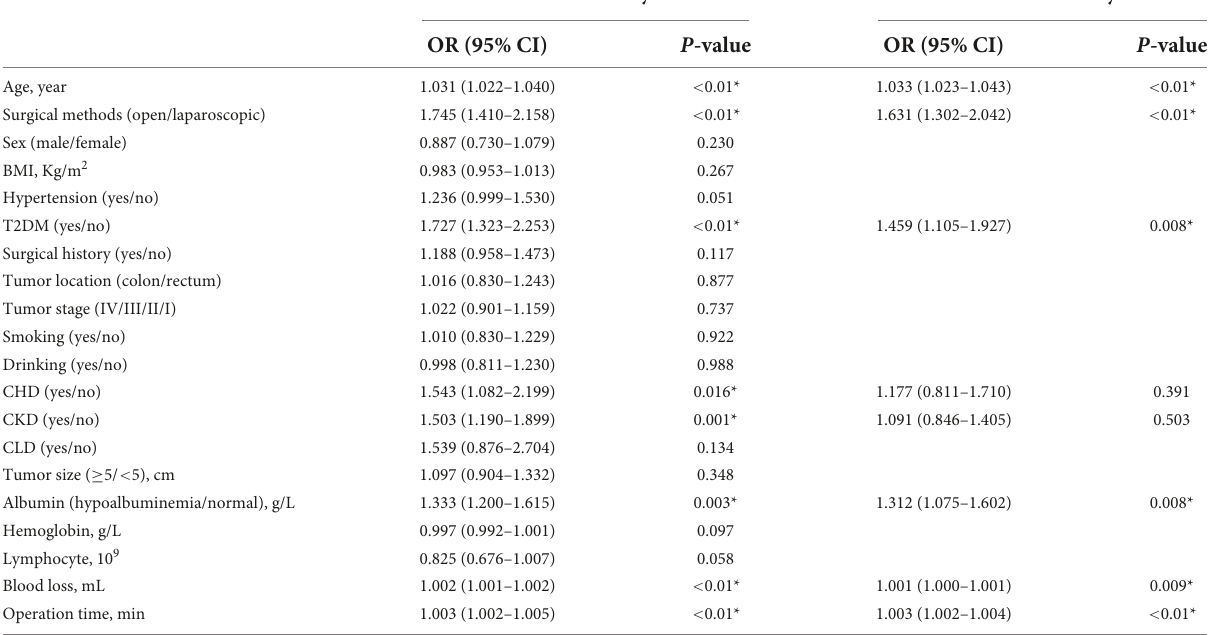
TABLE 3 Univariate and multivariate logistic regression analysis of the overall complications. Risk